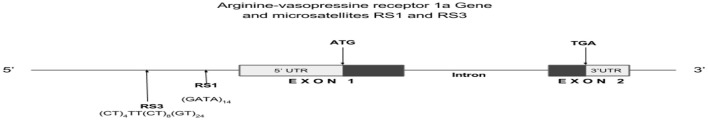
Arginine-vasopressin receptor 1a gene schema with location of microsatellites RS1 and RS3.